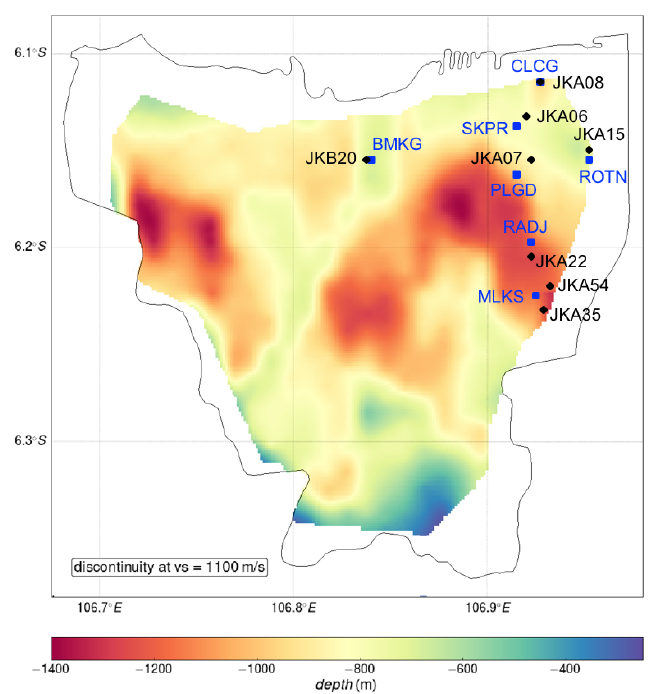
Figure 2. The bedrock-depth is defined as medium having shear-wave velocity V S = 1300 m/s, hence the geometry of the basin is defined. The labelled black diamonds and blue squares are HVSR and SPAC co-located stations. The black rectangle is station where ground motion is calculated from SPECFEM2D simulation.